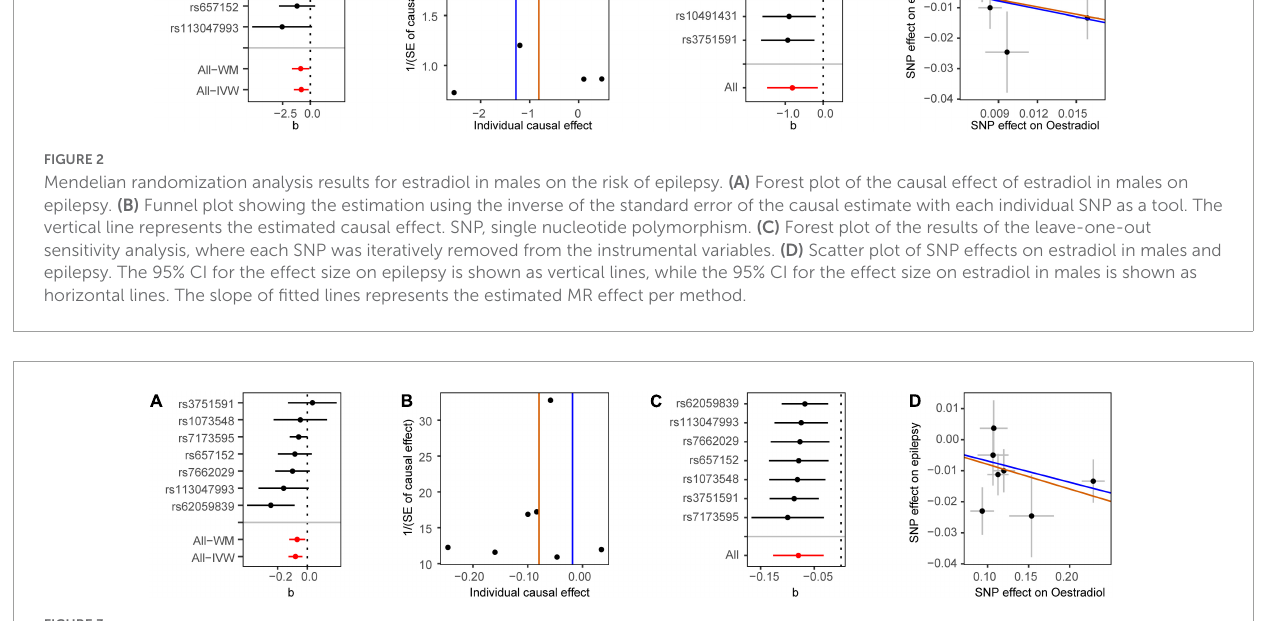
to estrogens in regulating brain functions (Azcoitia et